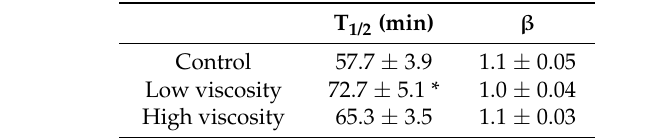
Table 4. Gastric emptying half-time (T 1/2 ) and shape of the emptying curve ( β ) observed on the 3